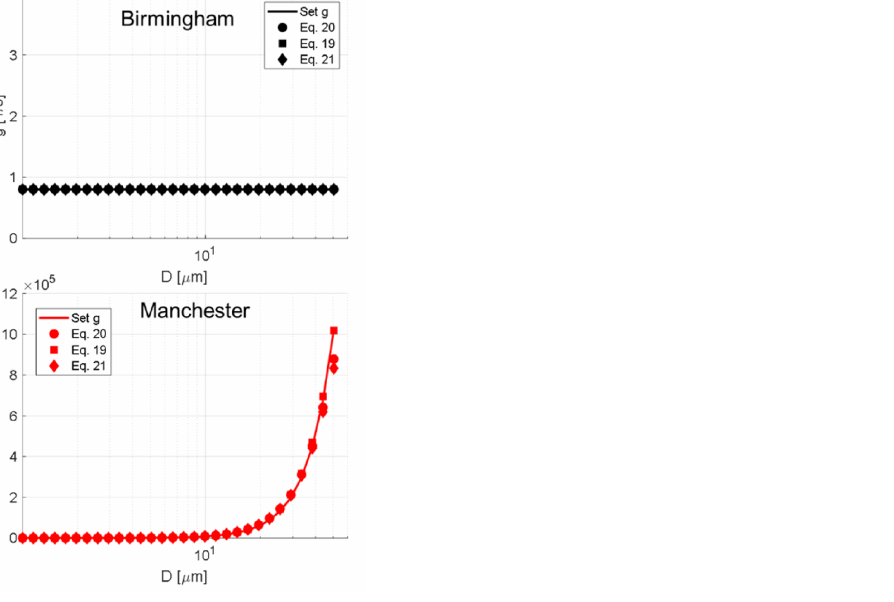
Figure 6. Sensitivity of the different methods to the choice of f . Panes compares set fragmentation rates obtained by equal size fragments, Equation (19) (solid lines) to estimations using a range of assumed f shapes (circles: Equation (20), squares: Equation (19), and diamonds: Equation (21)). Showing the Birmingham method (top row) and the Manchester method (lower row).